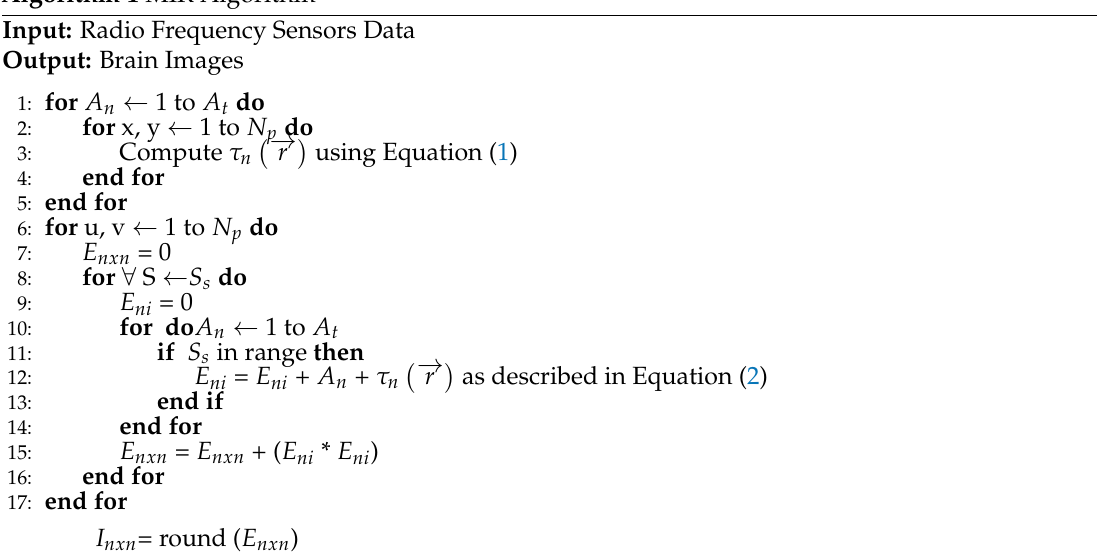
Algorithm 1 MIR